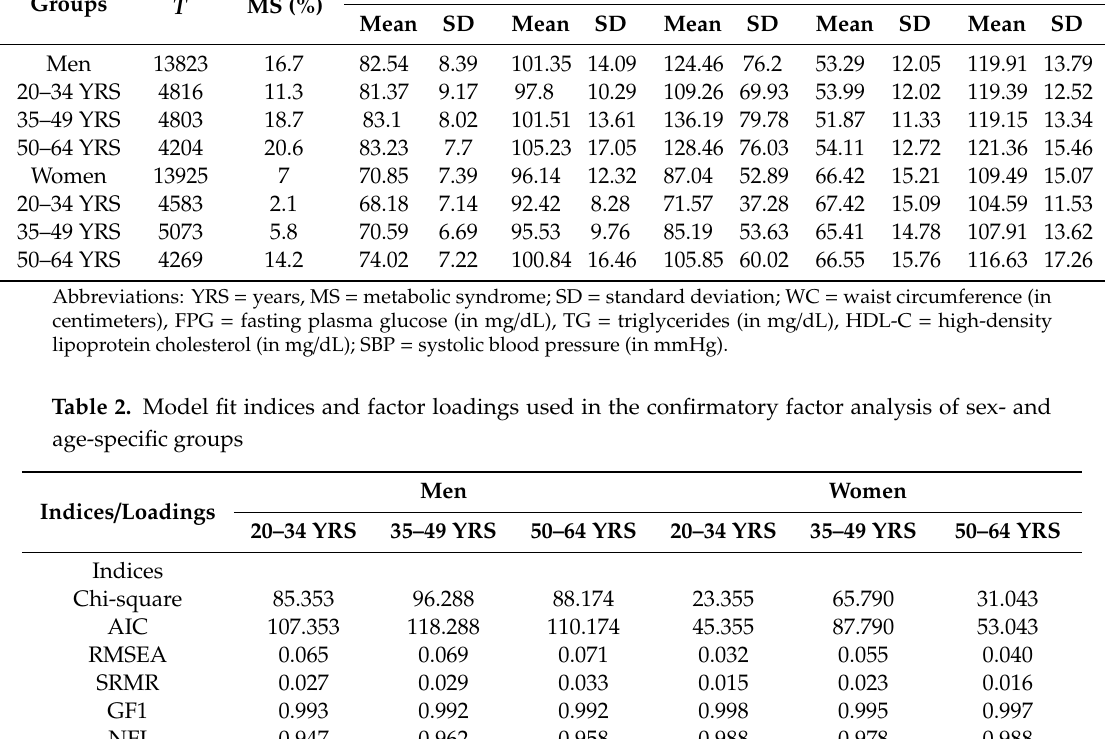
Table 1. Metabolic syndrome and its components for sex- and age-specific groups Groups